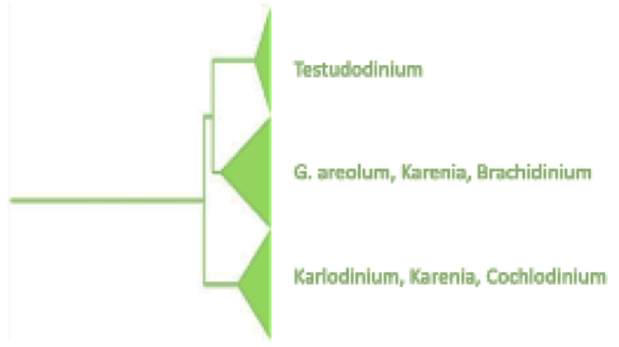
Figure 8. Enlarged view of the two major clades 3A i, ii, iii, iv and 3B.